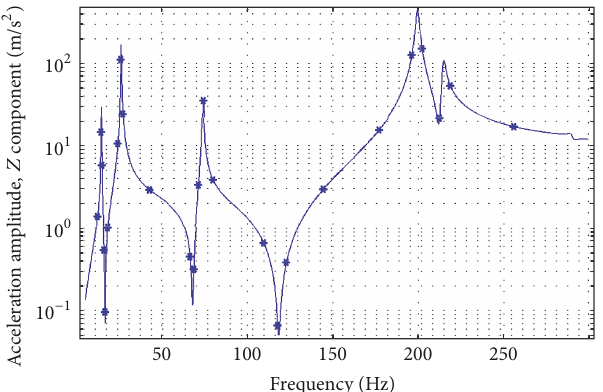
Figure 5: Acceleration amplitude versus excitation